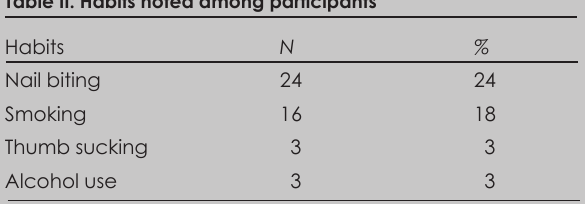
Table II. Habits noted among participants